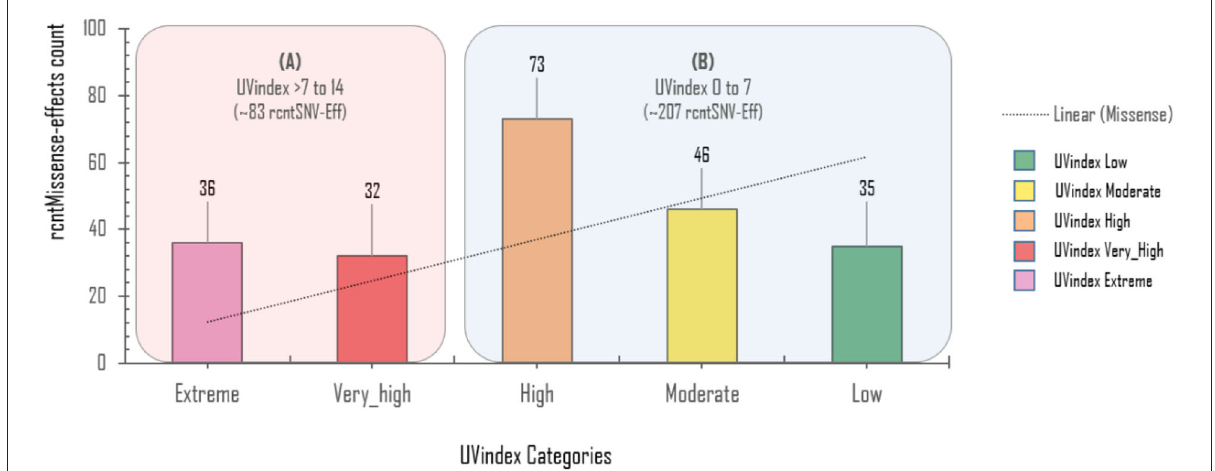
FIGURE7 Per UVindex category-specific rcntMissense-effects (CaSp-rcntMissense) count. The bars from left to right shows the total identified number of CaSp-rcntMissense effects in extreme (43; 14.8%), very high (40; 13.7%), high (92; 31.7%), moderate (65; 22.4%), and low (50; 17.2%) UVindex categories. The plot (A) reveals countries with UVindex above seven impose strong negative selection pressure by allowing least number of SARS-CoV-2 variants with minimal identified CaSp-rcntMissense effects ( ∼ 28.62%), whereas, (B) most number of CaSp-rcntEffs ( ∼ 71.38%) are observed in group of countries experiencing UVindex from 0 to